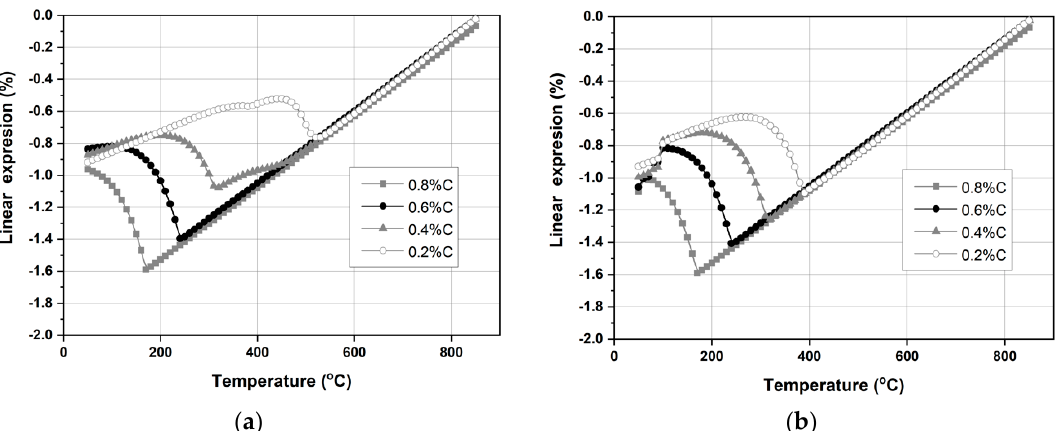
Figure 3. Linear expression change depending on temperature and carbon concentration; ( a ) for cooling rate 10 °C/s; ( b ) for cooling rate 60 °C/s.